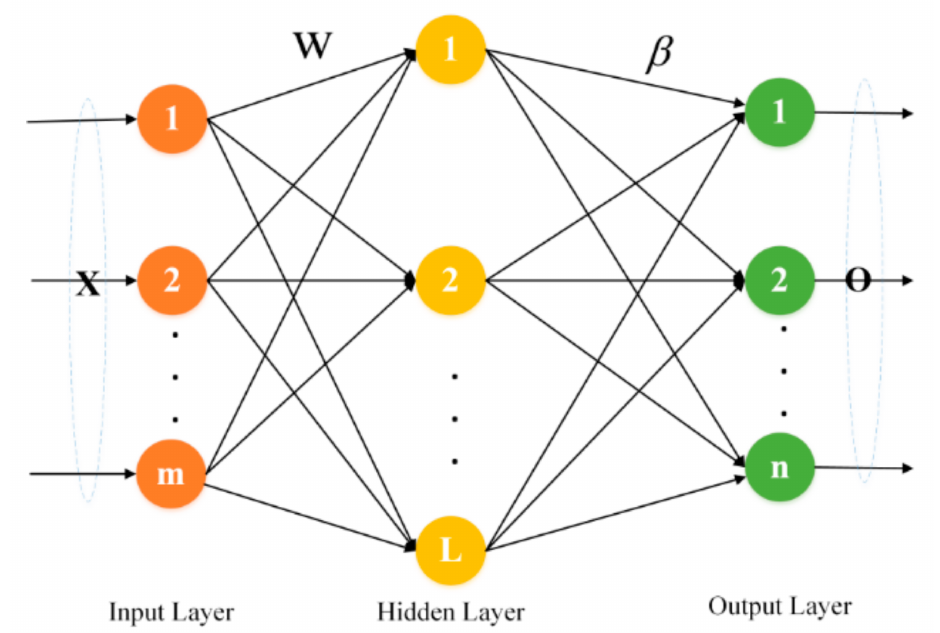
Figure 1. The network structure of the extreme earning machine